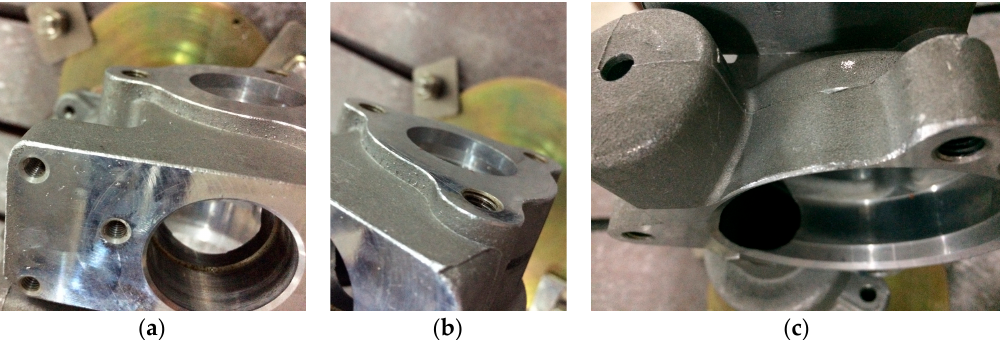
Figure 27. Experimental deburring of facet edges on proximal side facet.